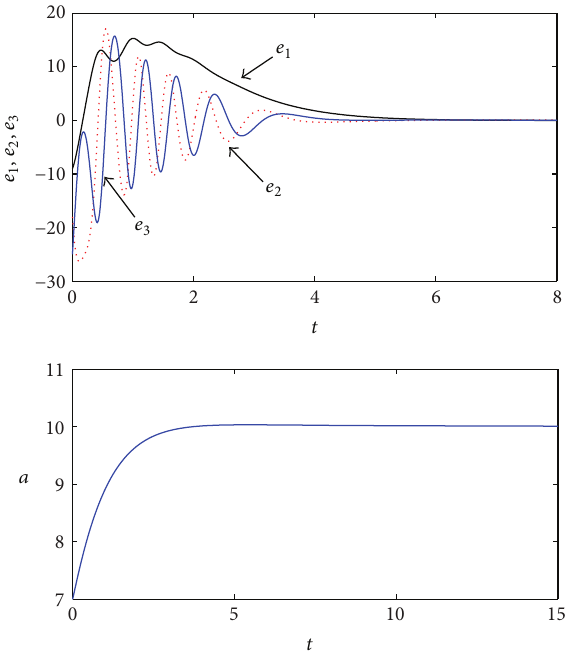
Figure 2: Simulation results of the adaptive synchronization for the fractional-order Lorenz chaotic system.